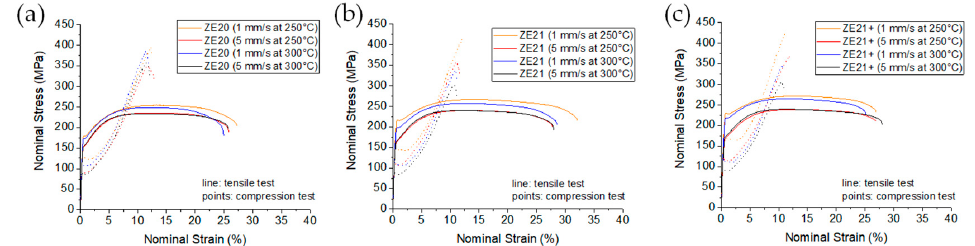
Figure 4. Stress–strain diagrams from tension and compression tests at ambient temperature: ( a ) ZE20; ( b ) ZE21; ( c ) ZE21+.